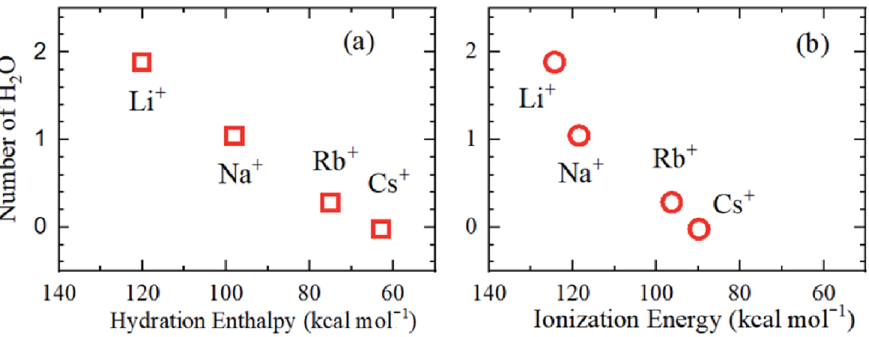
Figure 27. H 2 O numbers in the radial direction versus ( a ) hydration enthalpy and ( b ) ionization energy. Reprinted with permission from Ref. [112]. Copyright 2021 the Royal Society of Chemistry. Table 7. Moisture content λ , amount of water molecules per cation, self-diffusion coefficients D at 20 °C, self-diffusion activation energies E a of Li + , Na + , and Cs + cations in the Nafion membrane, MSC membrane at RH = 98%, and chloride aqueous solutions [35,60].